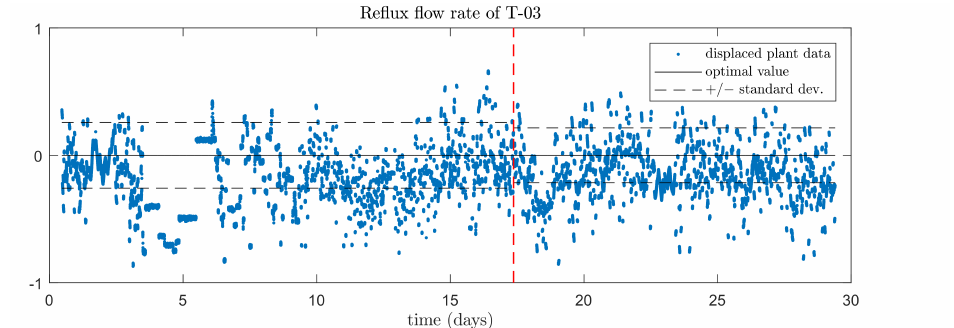
Figure 12. Optimization results: reflux flow rate of T-03 deviated from the optimal value before and after the RTO loop